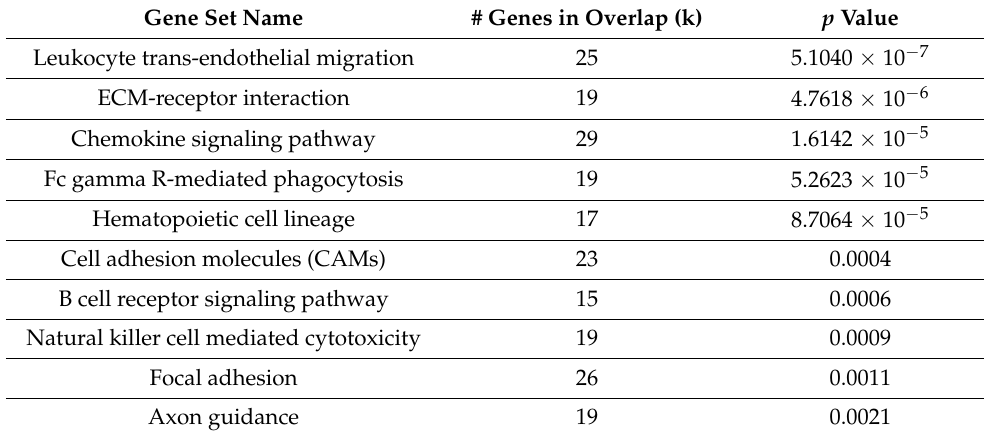
Table 1. Top 10 Enriched pathways.